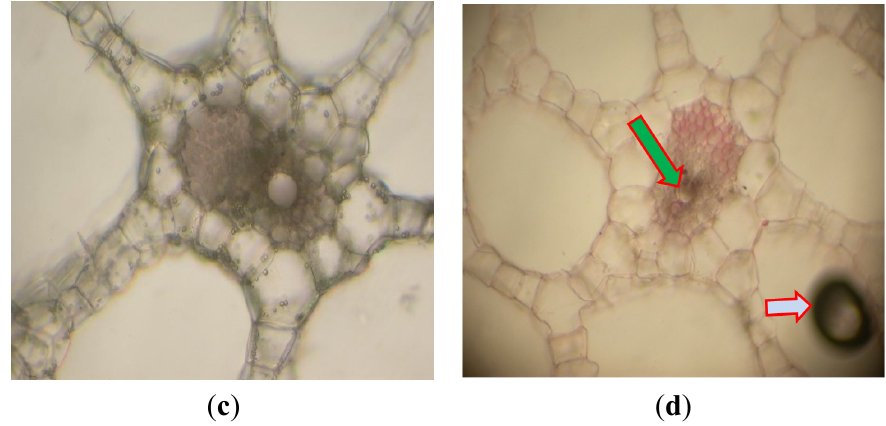
Figure 4. Cross sectioning of the root ( a , b ) and petiole ( c , d ) of water hyacinth before ( a , c ) and after treatment ( b , d ) of domestic wastewater (50× magnification). Presence of